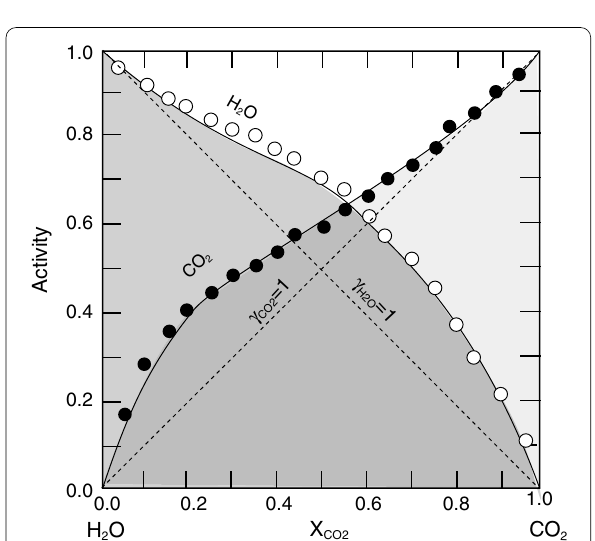
Fig. 31 Experimentally determined activity-composition relations along the H 2 O–CO 2 join at 800 °C and 1.4 GPa. Data points are from experimental results by Aranovich and Newton (1999) and calculated curves from Duan and Zhang (2006). Curves denoted γ CO2 γ H2O 1 indicate lines of ideal mixing =